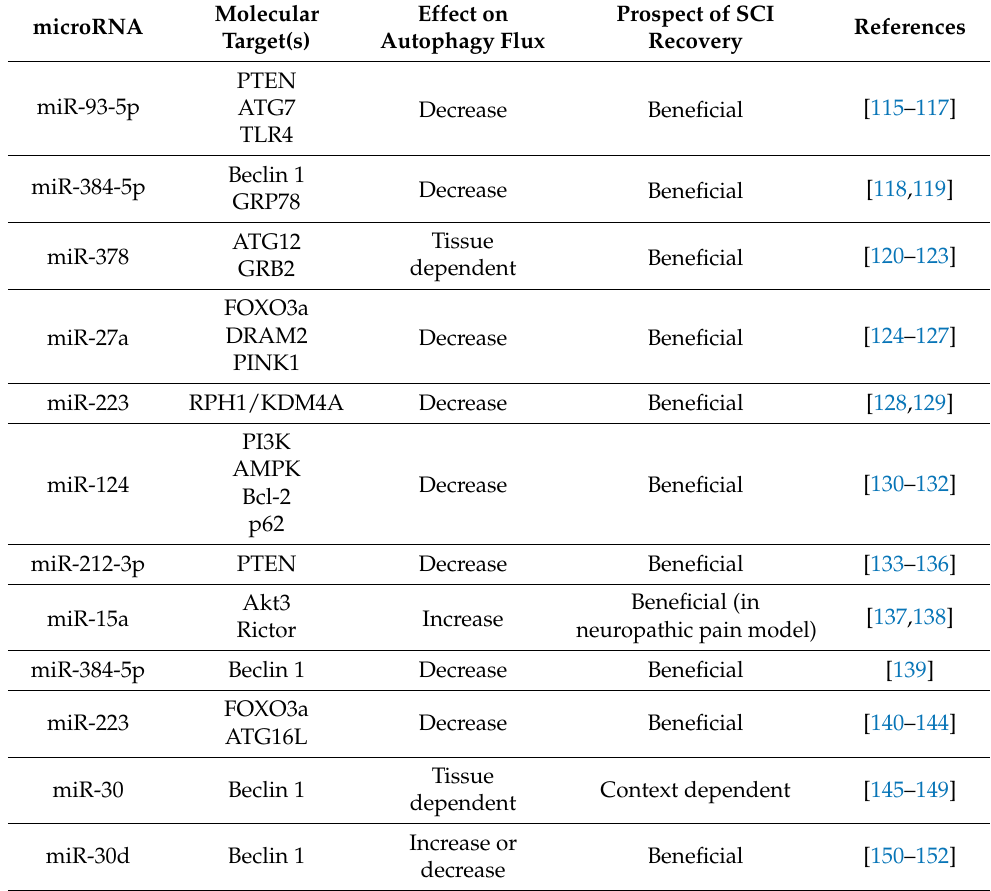
Table 1. Specific miRNAs in modulating autophagy with prospect of influencing SCI